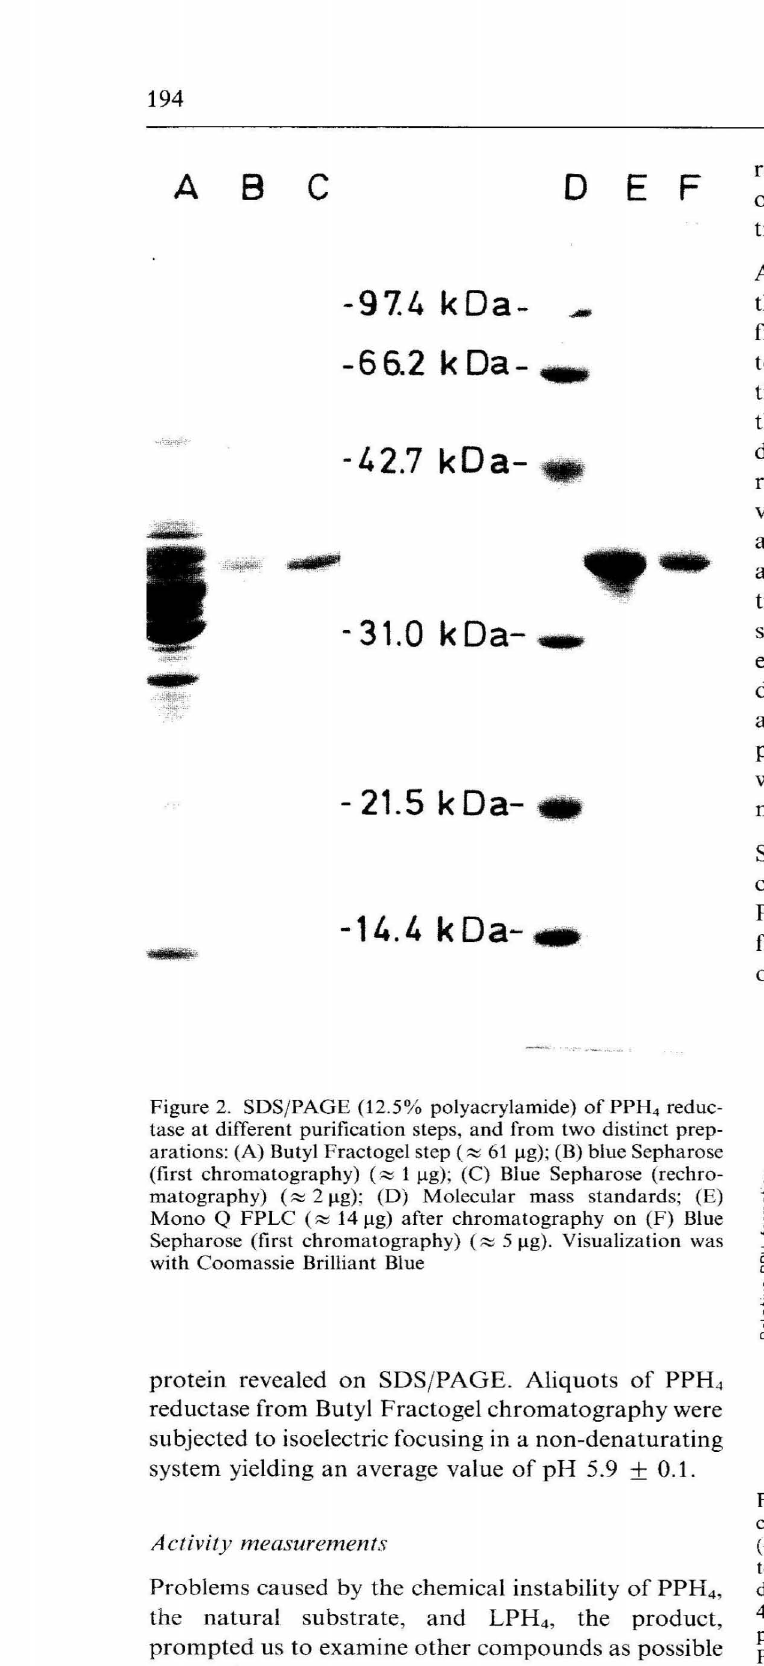
protein revealed on SDS/PAGE. Aliquots of PPH reductase from Butyl Fractogel chromatography were subjected to isoelectric focusing in a non-denaturating system yielding an average value of pH 5.9 ± 0.1.